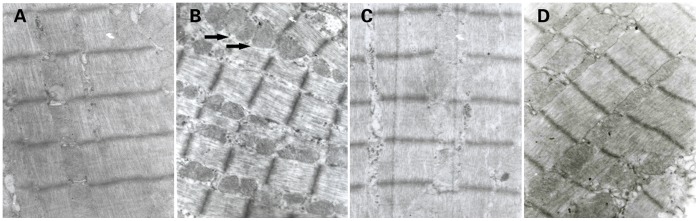
Cardiac lesions measured by transmission electron microscopy.A: NC group (n = 10). Note the regular membrane and intercalated disc between adjacent myocytes. B: MS group (n = 10). Interrupted capillary membrane, and derangement and increase of myofibers and mitochondria in cardiomyocytes were visible. Swollen mitochondria were shown by the arrows. C: MS+A group (n = 11). D: MS+H group (n = 11). Compared with MS group, the ultrastructural changes of drug-fed groups were obviously improved. Original magnification: ×10, 000.